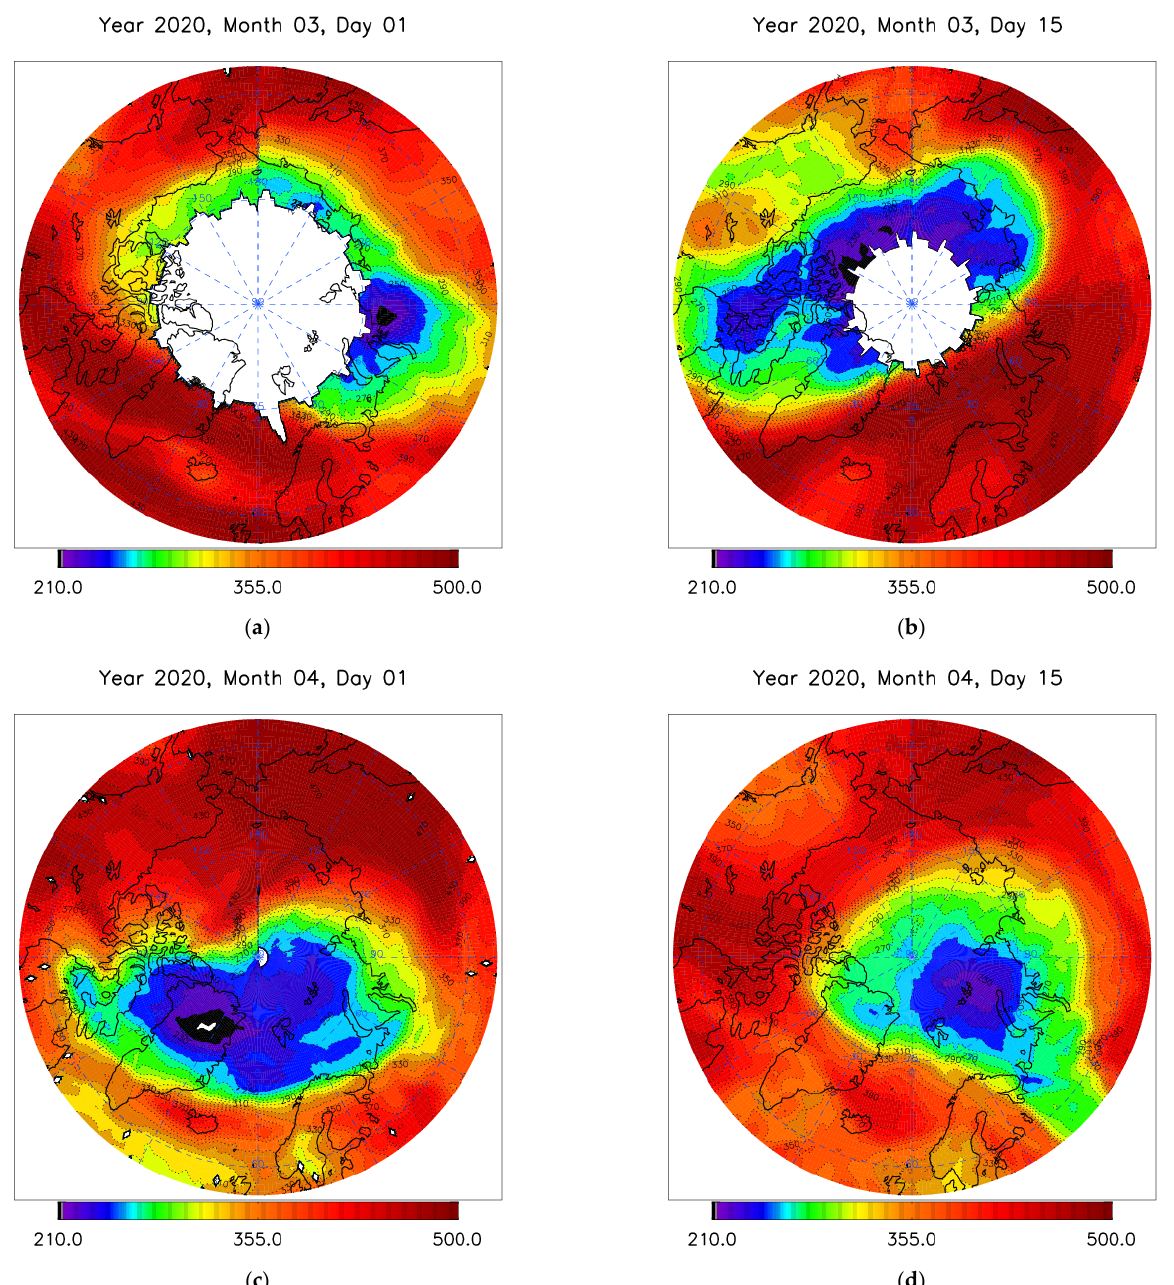
Figure 1. OMI Arctic column ozone (Dobson Units) during 2020 spring: ( a ) 1 March 2020; ( b ) 15 March 2020; ( c ) 1 April